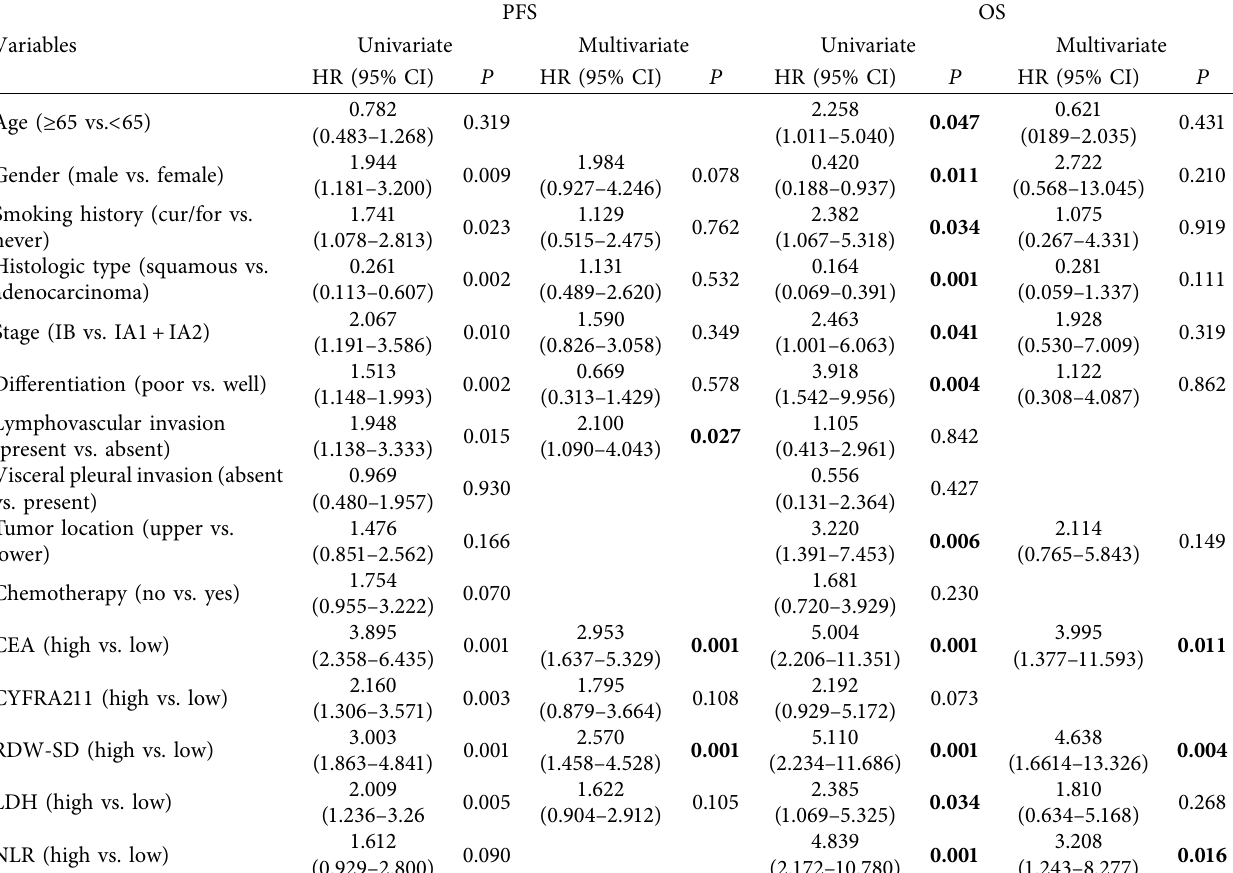
Figure 3: Kaplan–Meier curves for progression-free survival (a) and overall survival (b) probability according to the preoperative NLR level. NLR: neutrophil-to-lymphocyte ratio. Table 3: Univariate and multivariate Cox regression analyses of PFS and